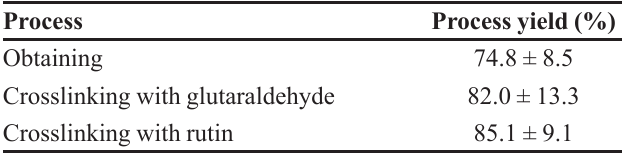
TABLE II - Microspheres process